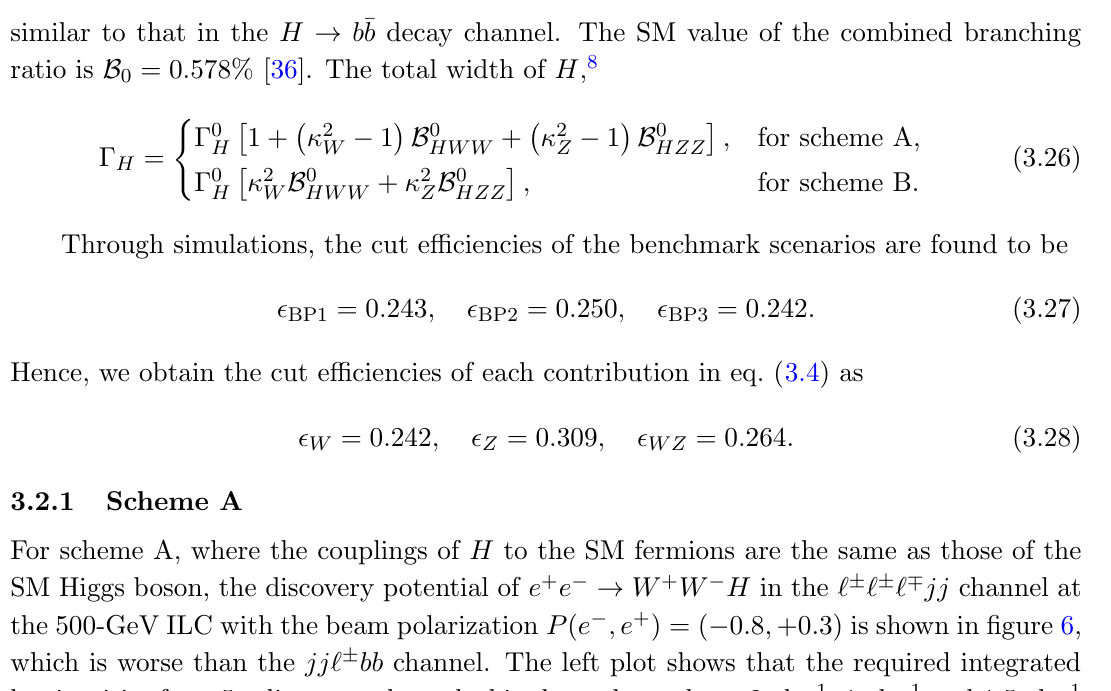
Figure 6 . Discovery potential of e + e (cid:0) 500-GeV ILC with the beam polarization P ( e (cid:0) ; e + ) = ( three scenarios as a function of the integrated luminosity. Right: contours of signal signi(cid:12)cance in (cid:20) W the - (cid:21) WZ plane, assuming an integrated luminosity of 4 ab (cid:0) 1 . j j